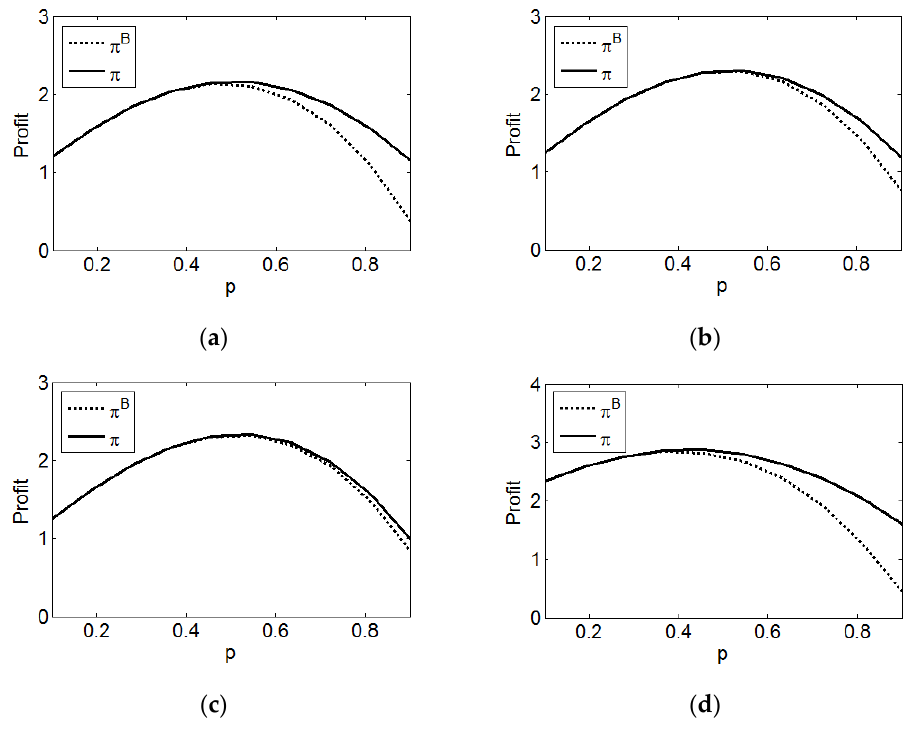
Figure 11. Impacts of p , δ , λ and r on the brand’s profit. ( a ) δ = 0.72, λ = 0.8, r = 0.2; ( b ) δ = 0.9, λ = 0.8, r = 0.2; ( c ) δ = 0.72, λ = 0.98, r = 0.2; ( d ) δ = 0.72, λ = 0.8, r =